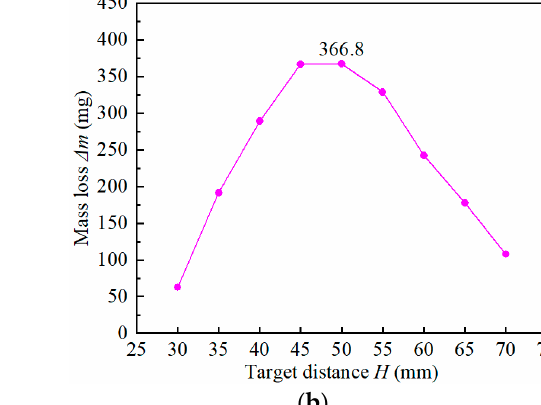
Figure 8. Dimensionless instantaneous cavitation intensity obtained by image processing: ( a ) at a working pressure of 10 MPa; ( b ) at a working pressure of 15 MPa.